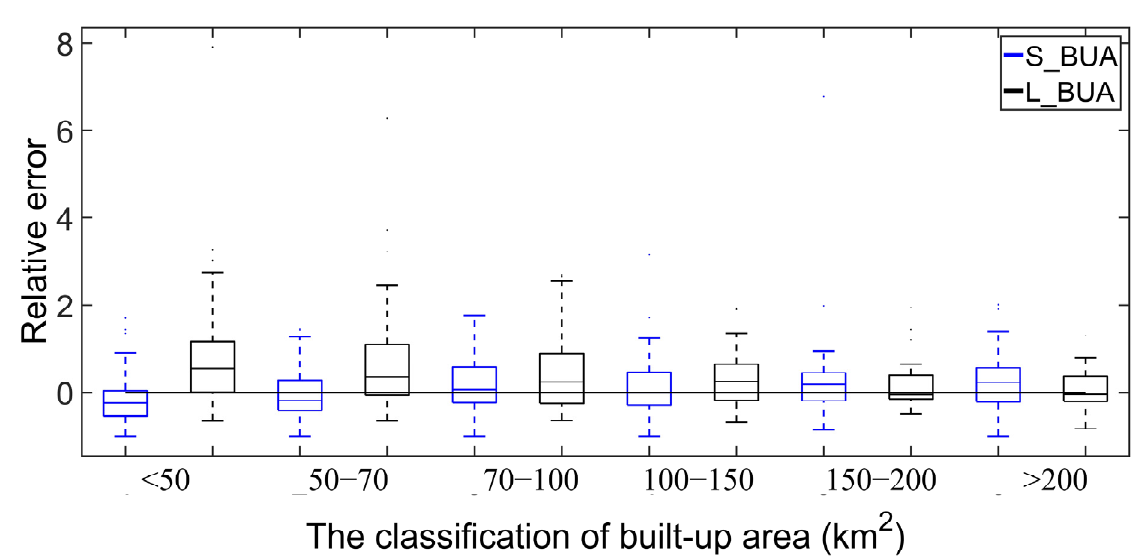
Figure 3. The relative error in 2015.